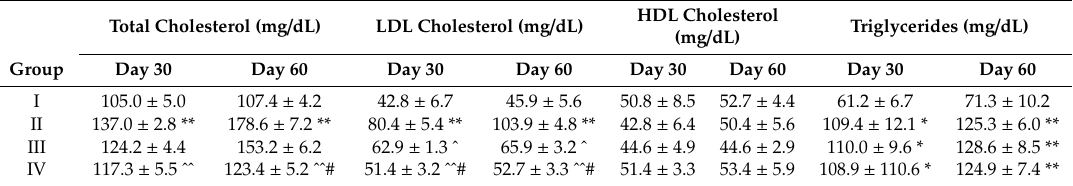
HDL Cholesterol Triglycerides (mg / dL) (mg / dL)